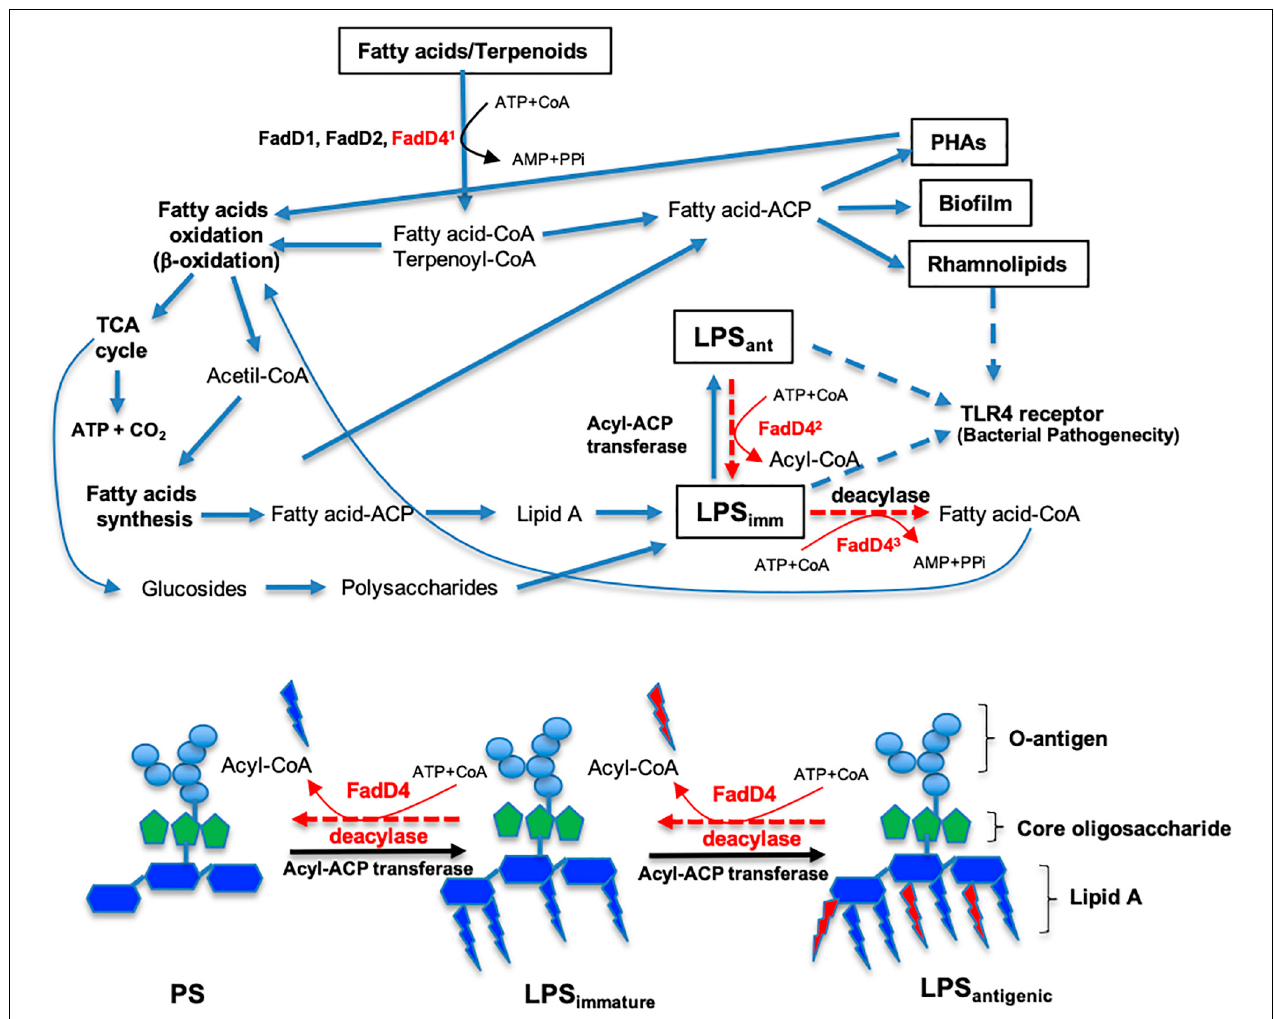
FIGURE 10 | Roles of the acyl-CoA synthetase (FadD4) from P. aeruginosa PAO1 on FA catabolism and LPS biosynthesis. The diagram shows the pathways related to fatty acid (FA) and acyclic terpene (AT) catabolism, as well as LPS biosynthesis from FA of external origin or from the FA biosynthesis cycle. Some steps are simplified and can be carried out by several enzymes acting sequentially. The steps where the FadD4 enzyme can act are indicated. First, the activation of FA or AT with coenzyme A (Co-A) directing FA oxidation ( β -oxidation) to obtain energy or storage compounds. Second, the elimination/incorporation of some FA on lipid A of the LPS structure to modify antigenicity. Third, a balance between the synthesis and degradation of LPS to recycle its structural compounds. The proposed activity of FadD4 in the modification of the lipid A component of LPS biosynthesis is shown below. PS, polysaccharides without FA lipid A. LPS imm indicates